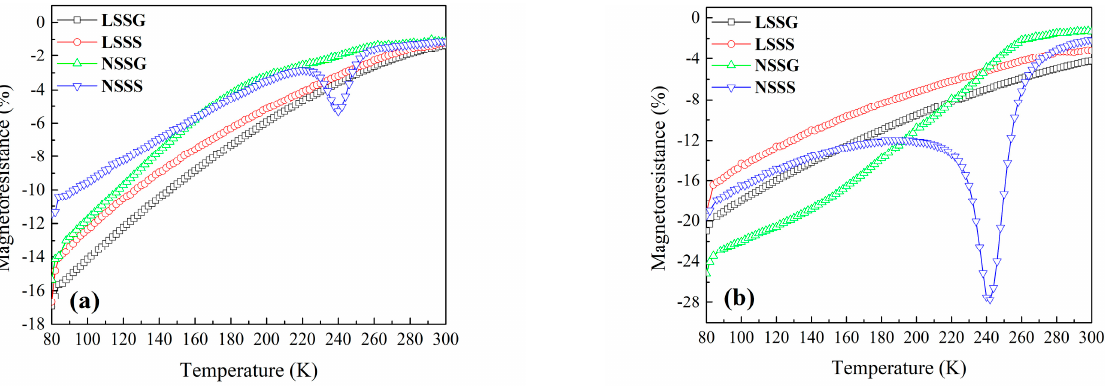
Figure 7. Temperature dependence of MR for LSMO and NSMO manganite samples at ( a ) 0.2 T and ( b ) 1 T.